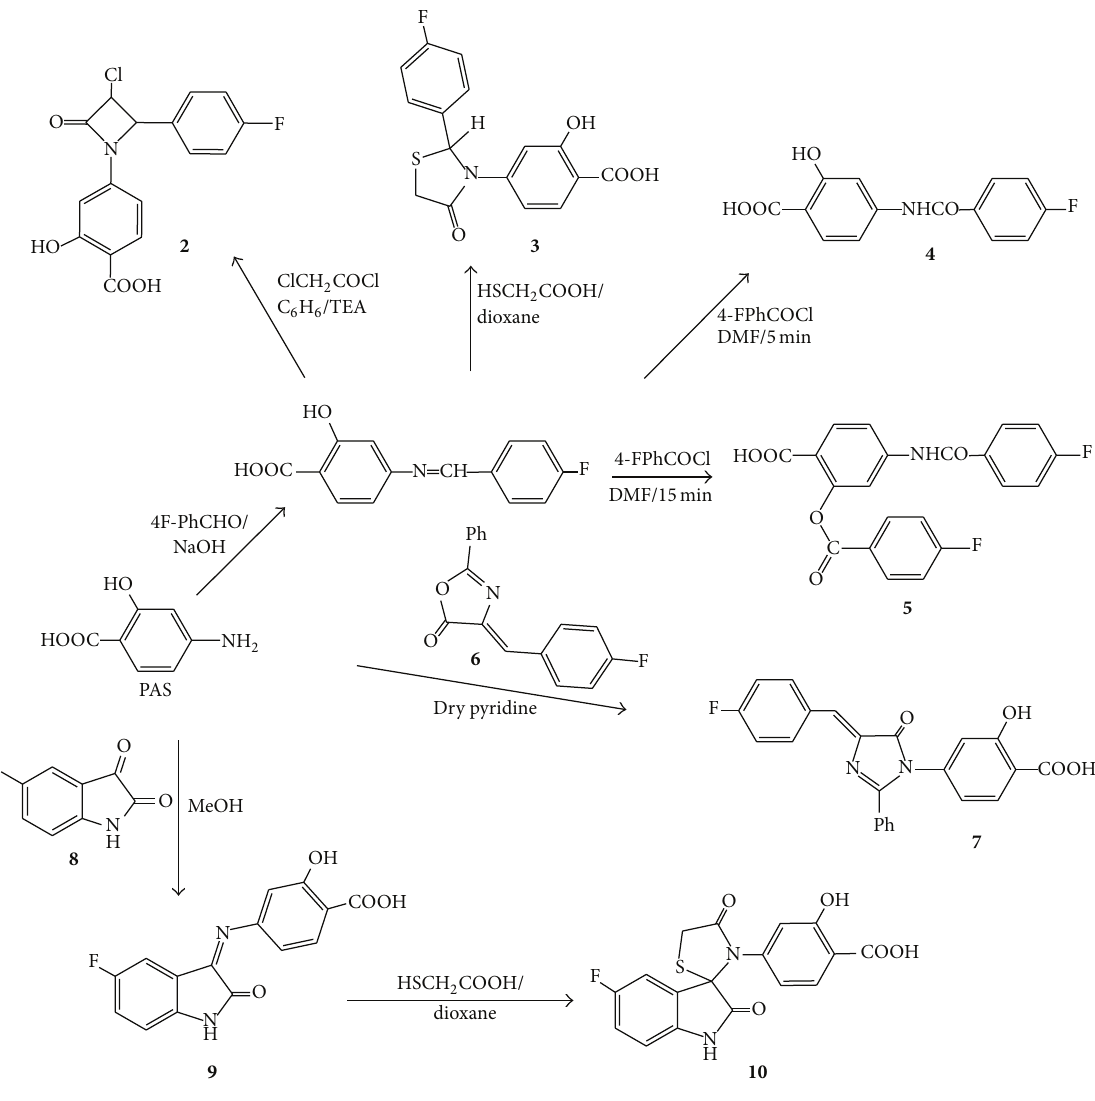
Scheme 1: Synthesis of p -aminosalicylic acid derivatives 1–5 , 7 , 9 , and 10 .